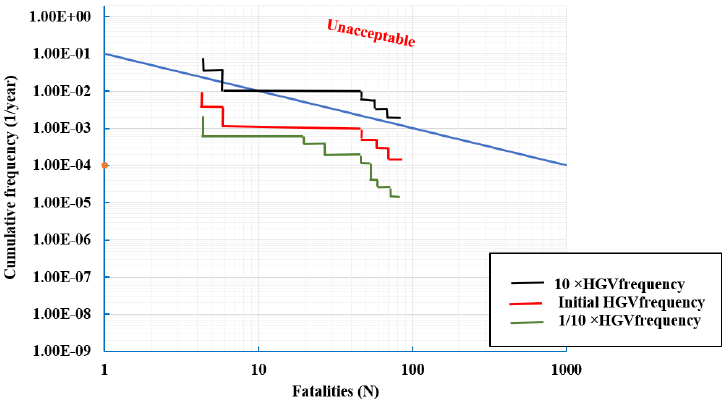
Figure 11. Sensitivity of the model to the parameter “HGV fire incident frequency”.